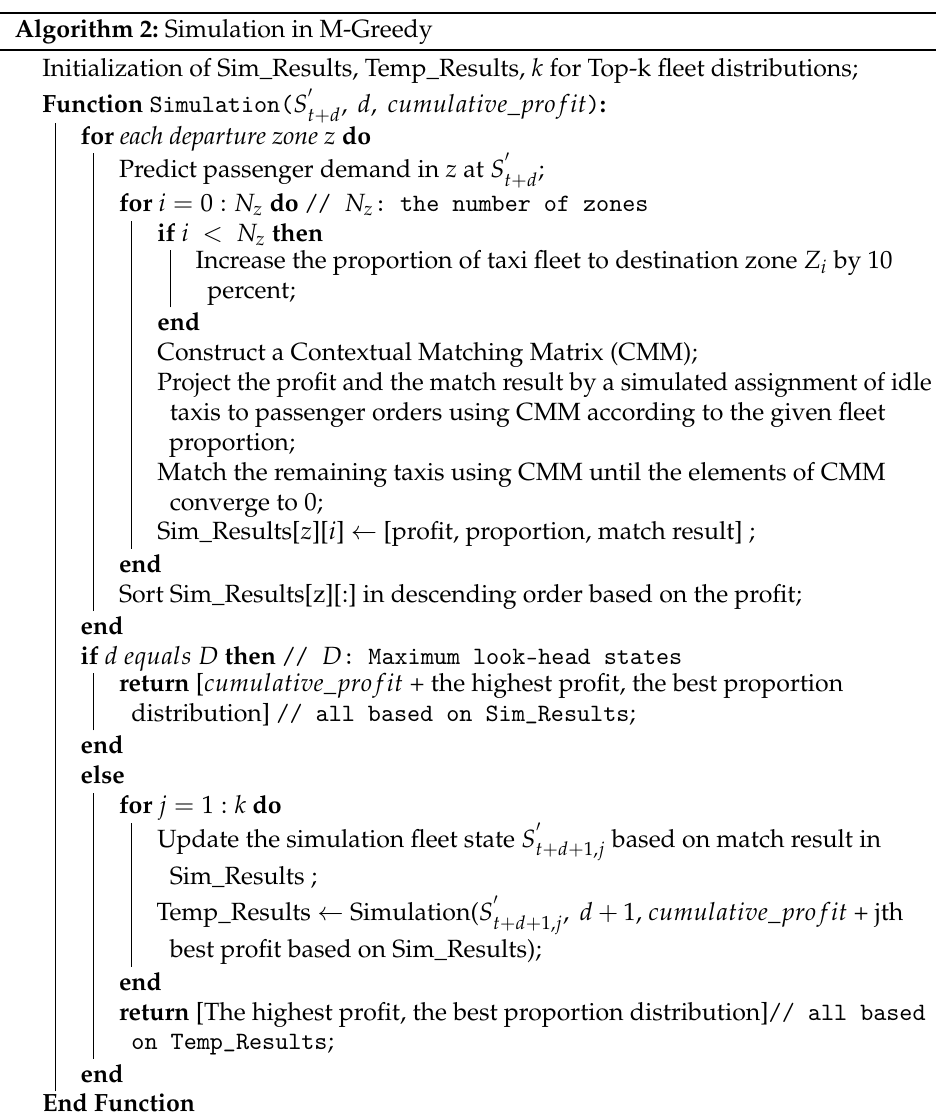
Algorithm 2: Simulation in